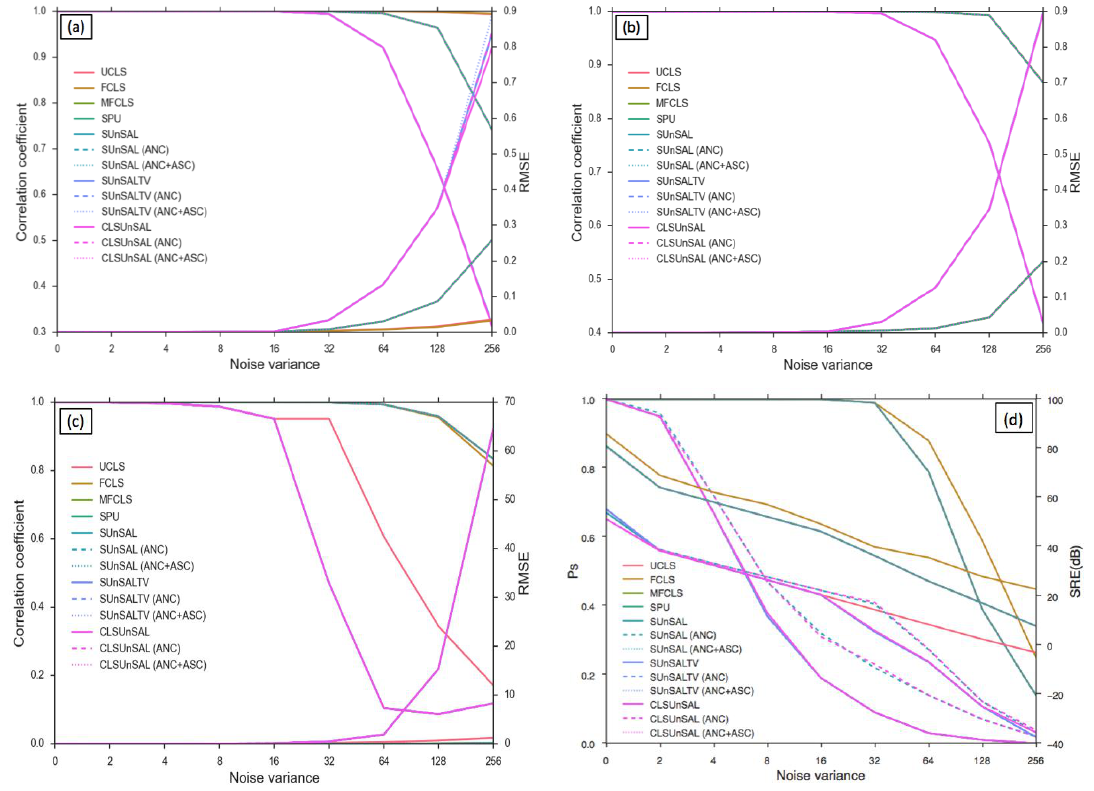
Figure 5. Correlation coefficient ( r ) and RMSE (root mean square error) between abundance values obtained from the seven algorithms and the true abundance for ( a ) endmember 1, ( b ) endmember 2, ( c ) endmember 3, and ( d ) plot of probability of success ( 𝑝 s ) and SRE (signal-to-reconstruction error in dB) at different levels of noise.